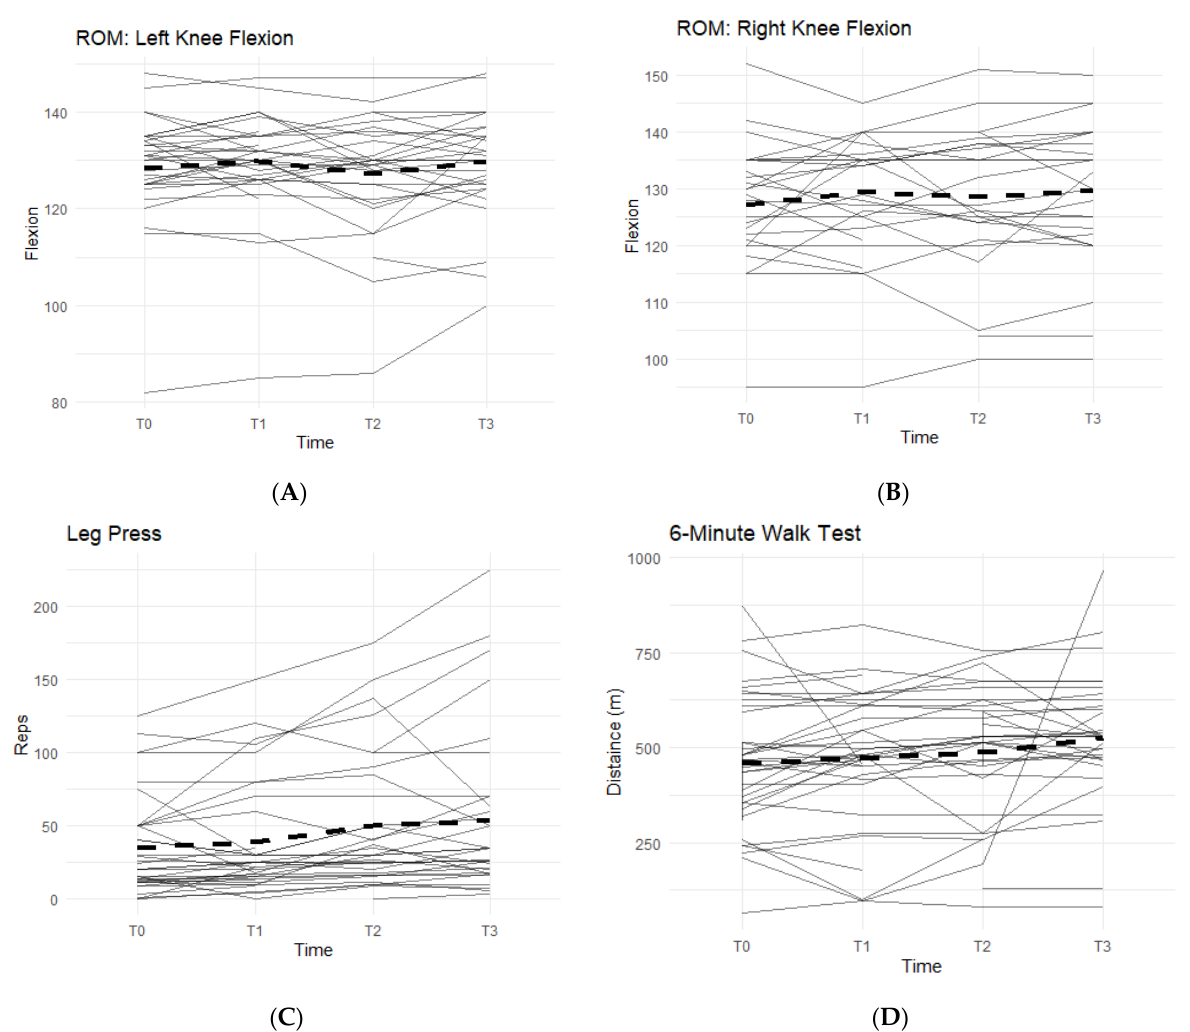
Figure 2. Bilateral Flexion, Leg Press, and Walk Test Changes Over Time During the Study Period. The figures show the changes in flexion of the left and right knees separately, and the changes in leg press repetitions and distance covered in a six ‐ minute treadmill walk. Only the results for the affected knees were included in each figure. Solid lines represent individual participant scores. Thick dashed lines represent group averages. ( A ) shows left knee flexion from T0–T3. ( B ) shows right knee flexion from T0–T3. ( C ) shows leg press reps from T0–T3. ( D ) shows the 6 ‐ min walk test from T0–T3.